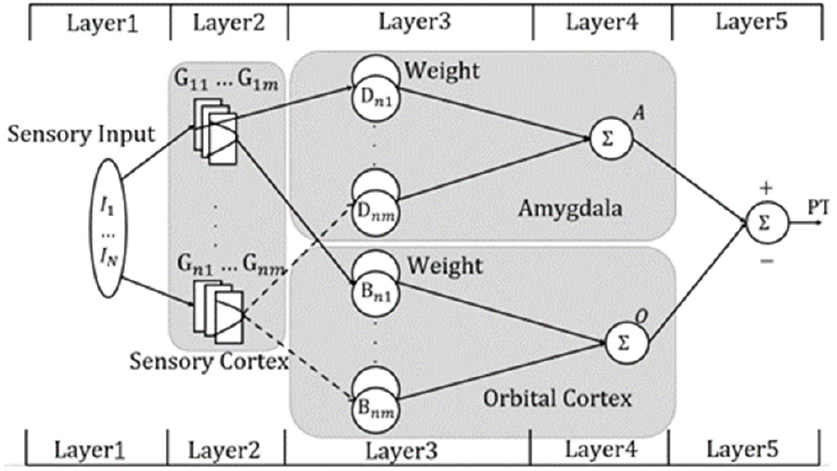
Figure 3. Structure of the FBEL neural network model.